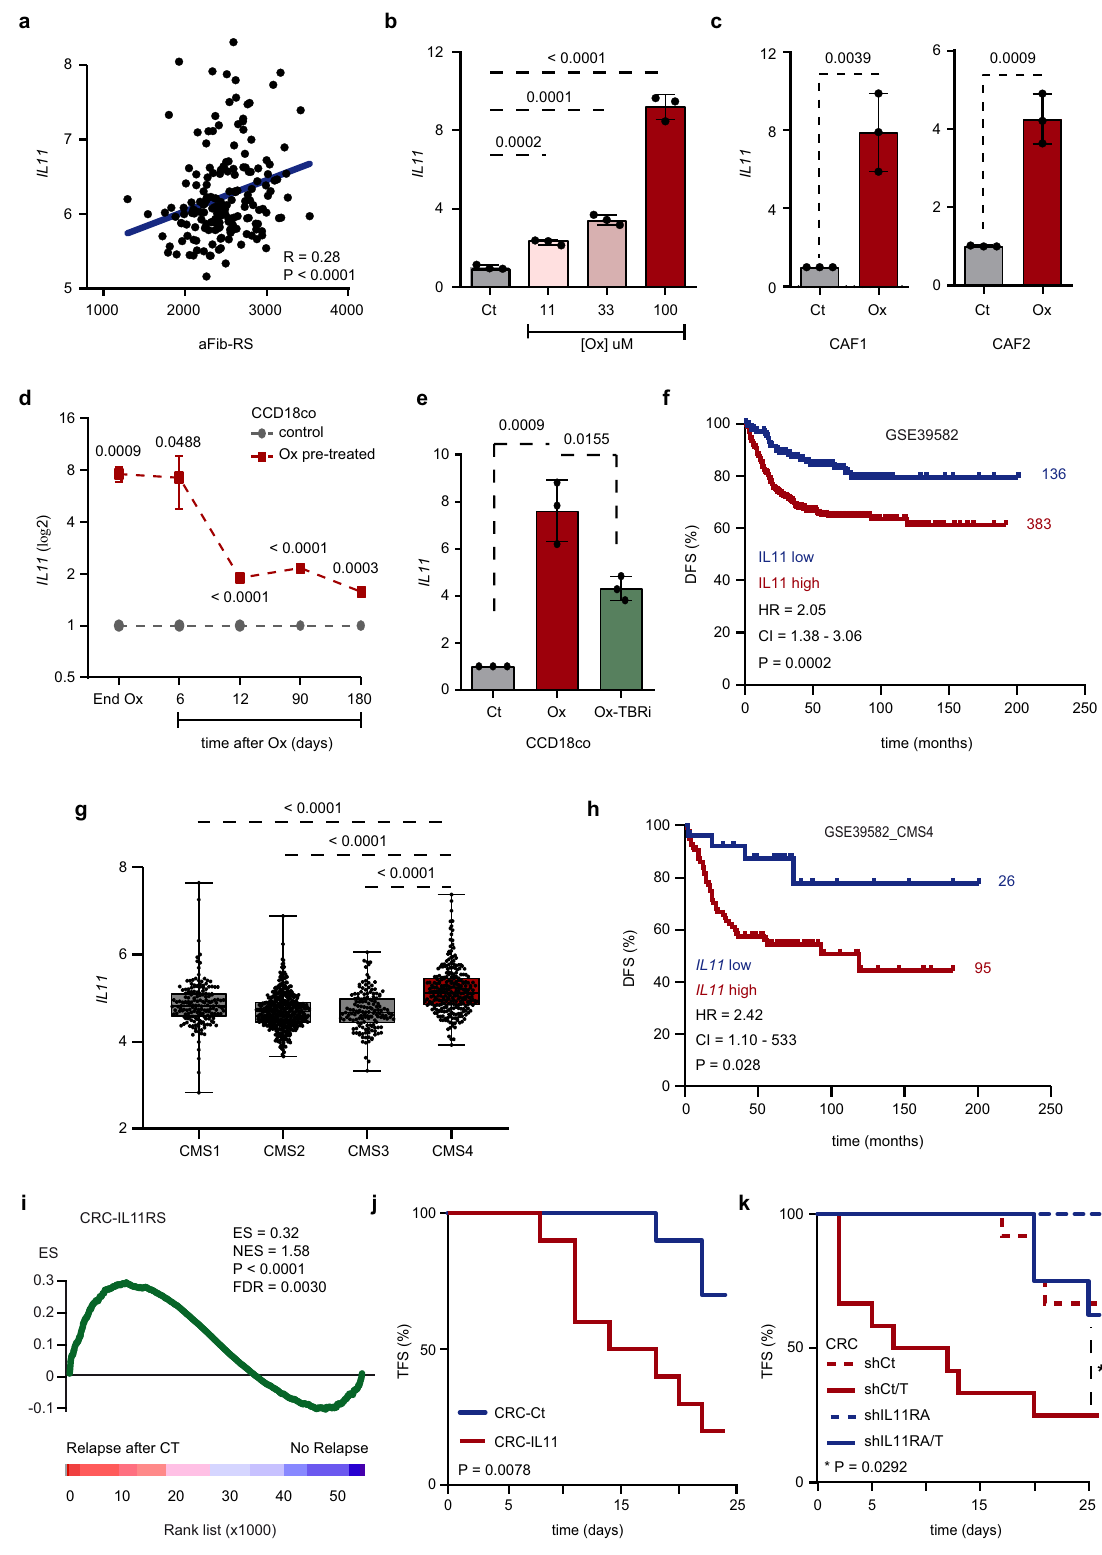
strategies blocking POSTNi4 expression may restore treatment ef fi - ciency in unresponsive patients. Transcriptomic analyses indicate that multiple additional soluble factors are upregulated in CAFs sti- mulated by platinum-based therapy (Supplementary Data 1). Among them, VCAN 63 , HBEGF 64 , NRG1 65,66 , GDF15 27 , MMP1 67 and ANGPTL4 68